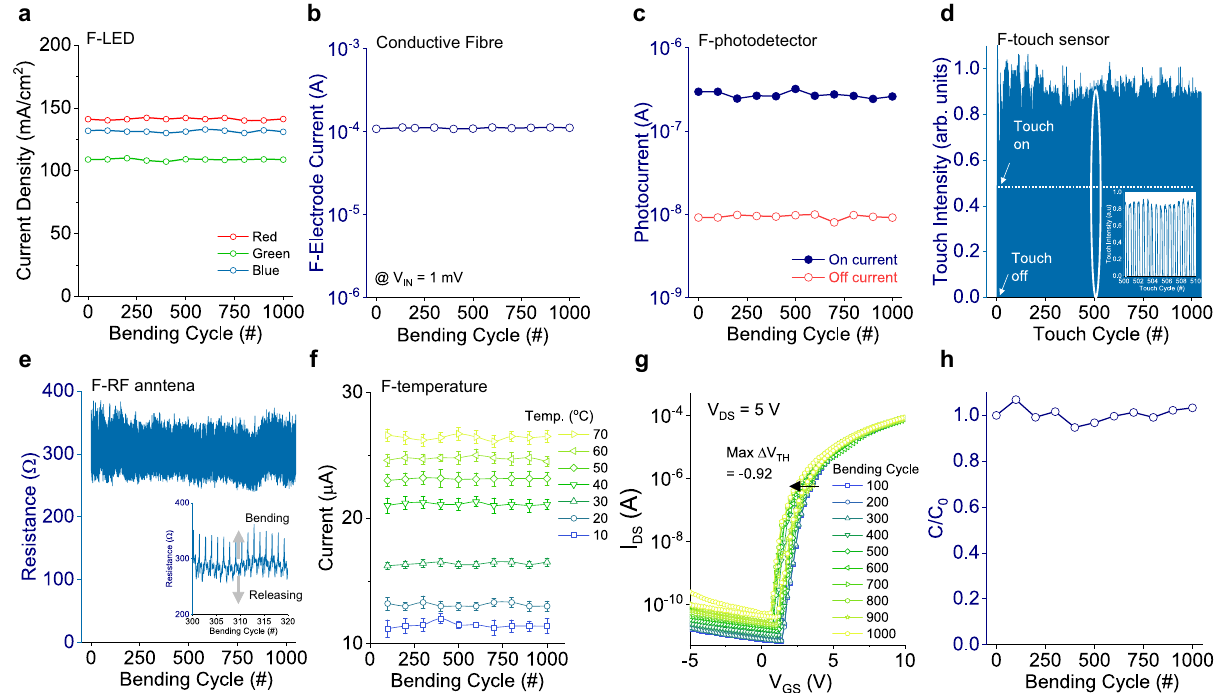
Fig. 3 Mechanical and electrical stability of F-devices, 1000 cyclic bending test with 10 mm radius. a F-LED showing no current density change. b Stable current of conductive fi bre. c F-photodetector showing clear on/off classi fi cation. d Cyclic touch attempts for evaluating surface weariness of F-touch sensor. e Stable resistance value of RF-antenna (Ag-PA conductive fi bre). f F-temperature sensor showing stable classi fi cation of measured temperature range as a function of electrical current. The error bars on the plot represent the standard deviation of measurements. g Unnoticeable transfer characteristics change of fi bre transistor used for F-biosensor module. h Mechanical damage-free from the bending for fi bre